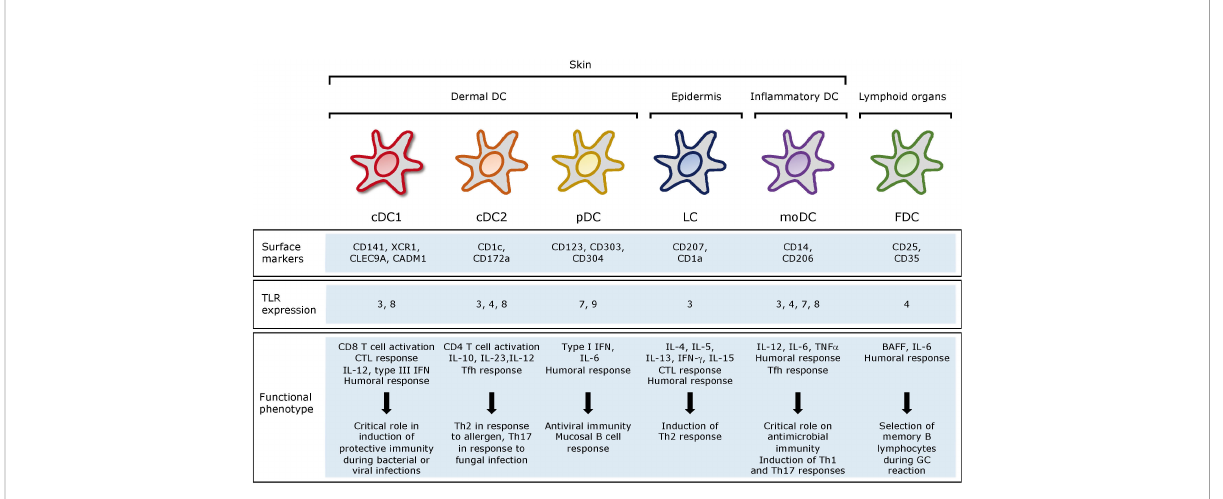
FIGURE 1 Subsets, location and function of human DC. cDC, conventional DC; pDCs, plasmacytoid DC; LC, Langerhans cells; moDC, monocyte derived DC; FDC, follicular DC; CTL, cytotoxic T lymphocytes; Tfh, T follicular